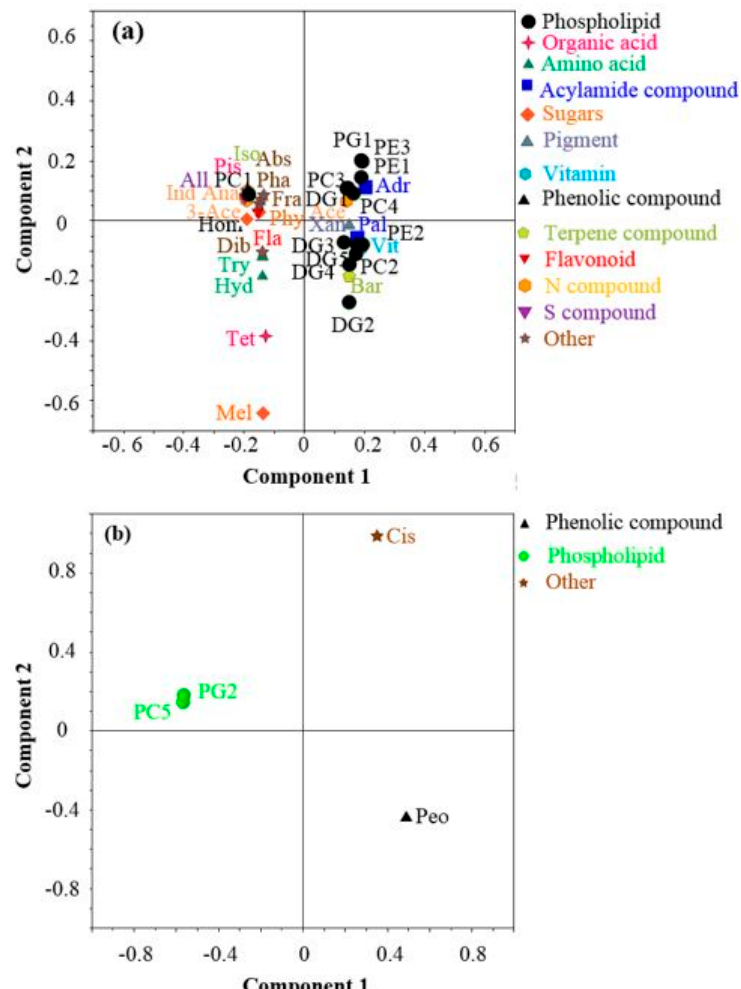
Figure 5. Partial least squares discriminant analysis (PLS-DA) loading plots of Component 1 and Component 2 of 41 plant metabolites from Cunninghamia lanceolata under the control and warming treatments. ( a ) ESI + mode, ( b ) ESI − mode. Refer to Table 3 for the abbreviations of plant metabolites identified in the leaves of C. lanceolata .